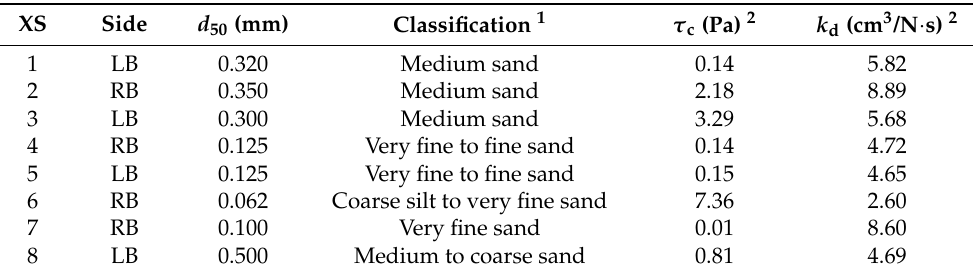
Table 2. Median grain size ( d 50 ), classification, and JET-derived erodibility parameters τ c and k d of the bank material at the chosen